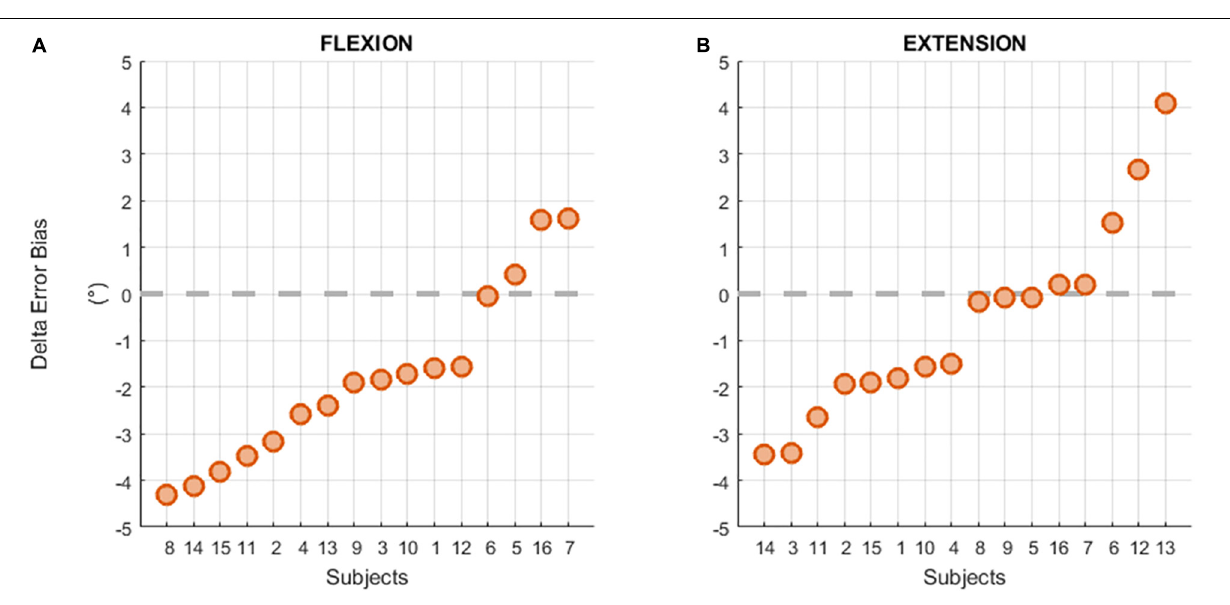
the target prior to the fatigue protocol ( − 1.535 ◦ ) compared